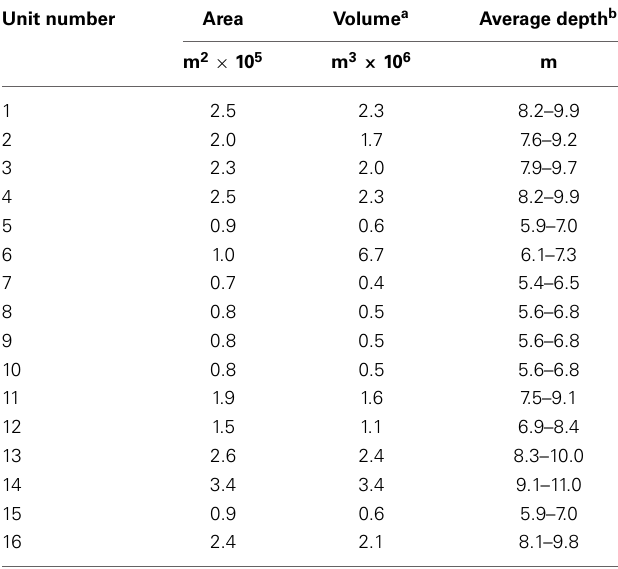
Table 1 | Area, inferred volume and average depth of the units shown in Figure